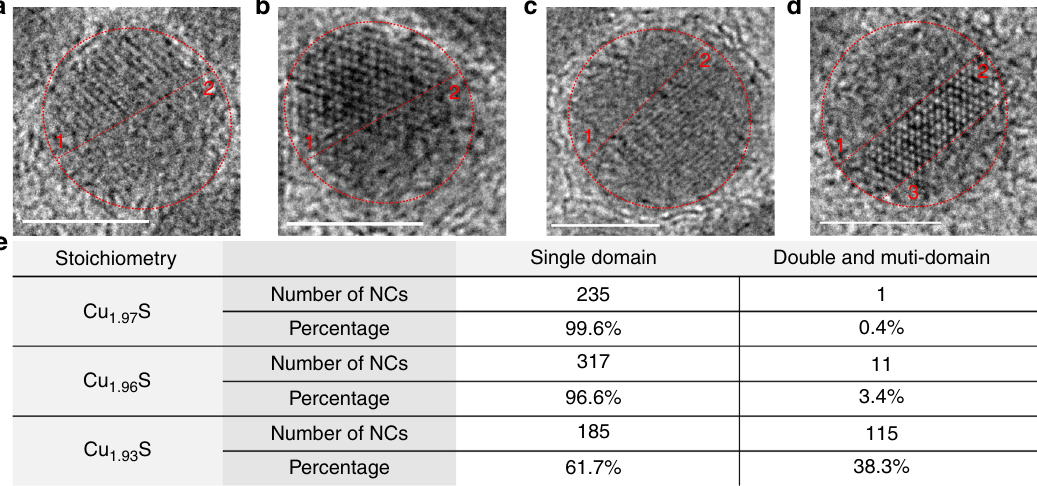
Fig. 2 Internal domain structure. Representative examples of Cu 1.93 S NCs with multiple domains apparent in HRTEM imaging: NCs exhibiting a – c two domains and d three domains. In a – d the NC boundary is marked by a dotted red circle and domain boundaries are marked by dotted red lines. Domains are labeled as 1, 2, and 3. All scale bars are 5 nm in length. e Table of statistics of NCs exhibiting single- or multi-domain structures for three levels of sub- stoichiometry. The statistics were determined by analysis of NCs imaged by